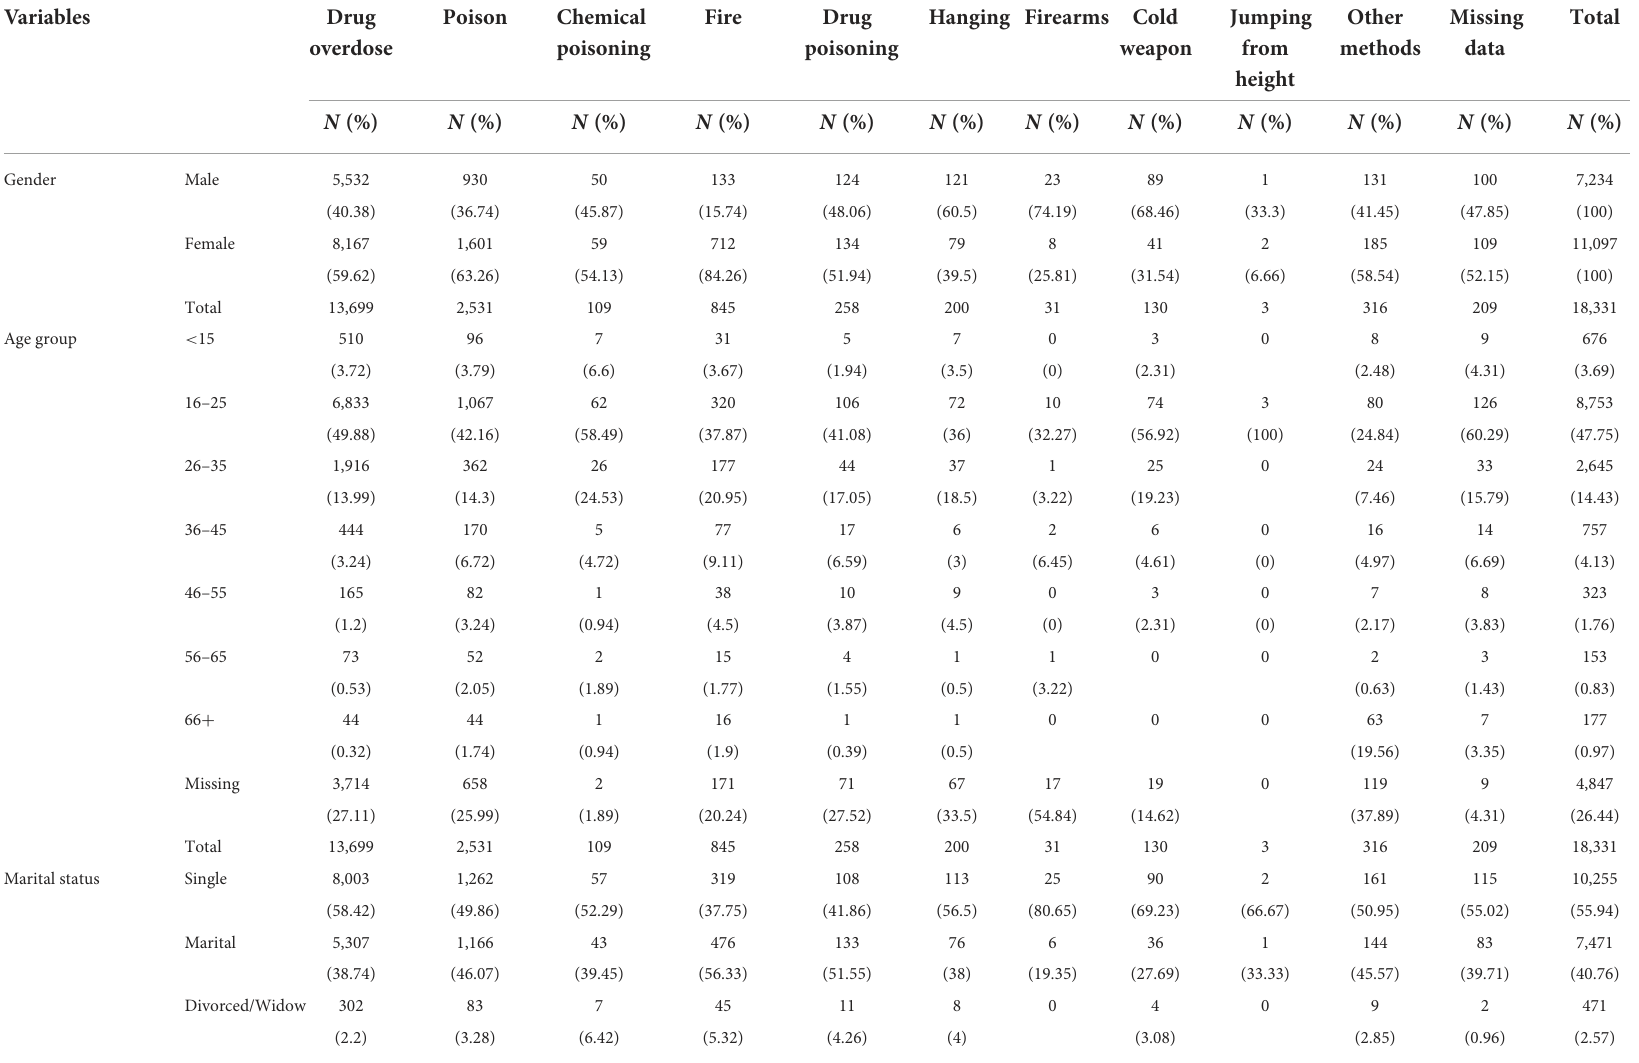
TABLE 1 Demographic characteristics of suicide attempts in Kermanshah province